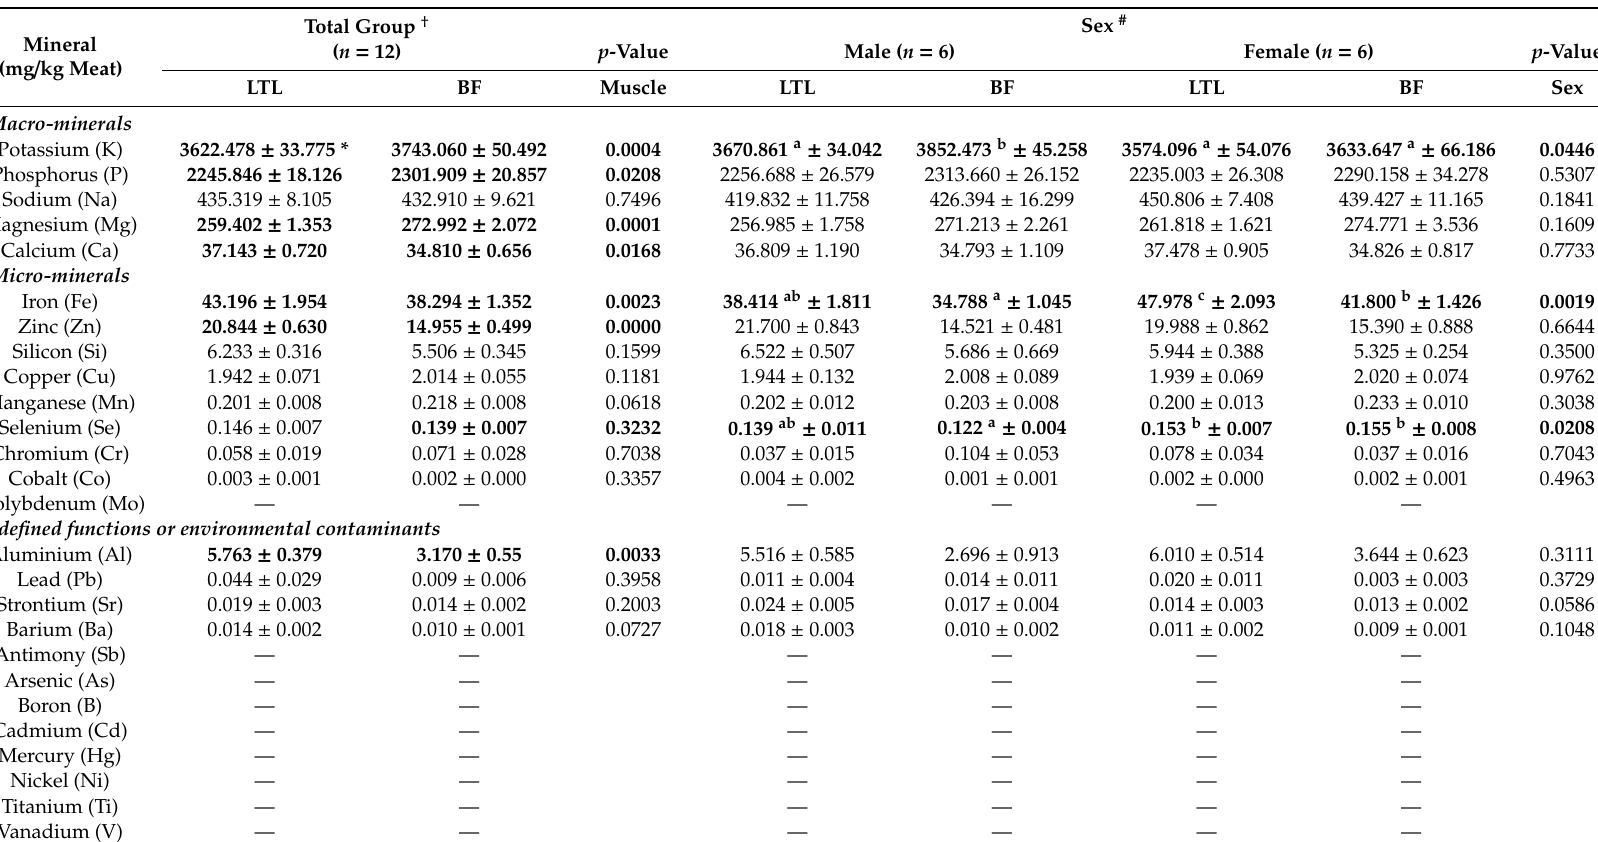
Table 2. Mean ( ± standard error) mineral composition (mg / kg meat) of fallow deer ( n = 12) longissimus thoracis et lumborum and biceps femoris , as influenced by muscle and sex. Dashed lines = not